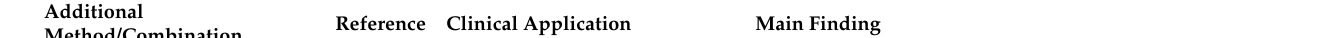
Table 1. Overview of potential clinical applications for EEG-fMRI combined with other